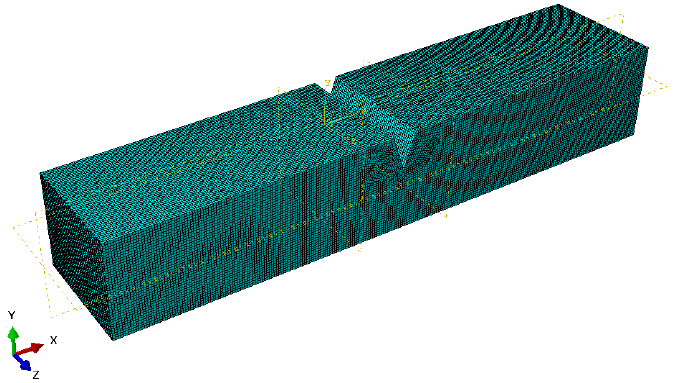
Figure 10. Meshing of the FEA model.